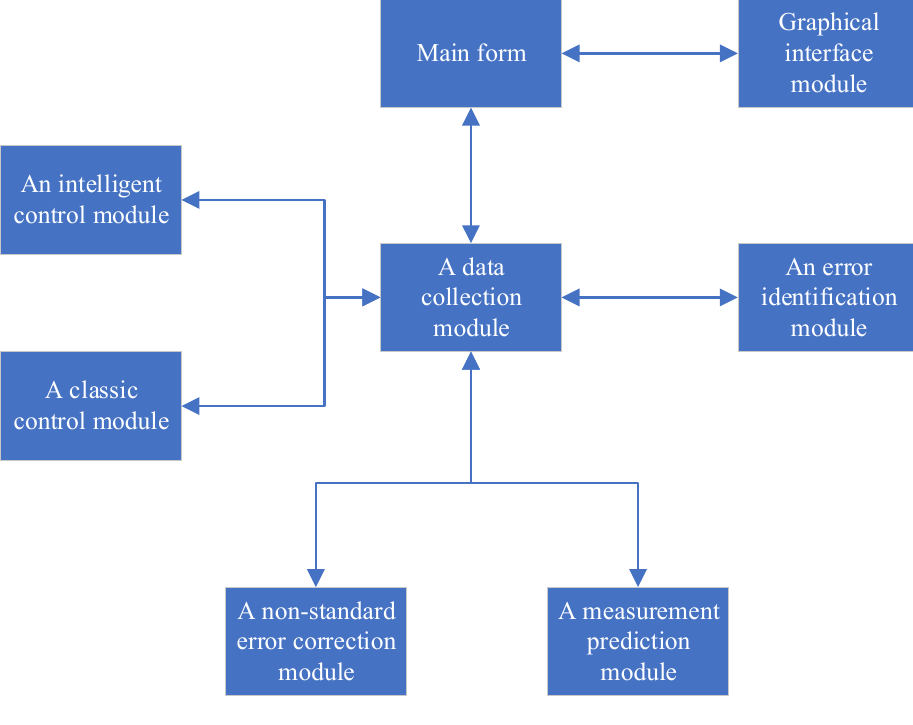
Figure 17. Structural diagram of the software product.